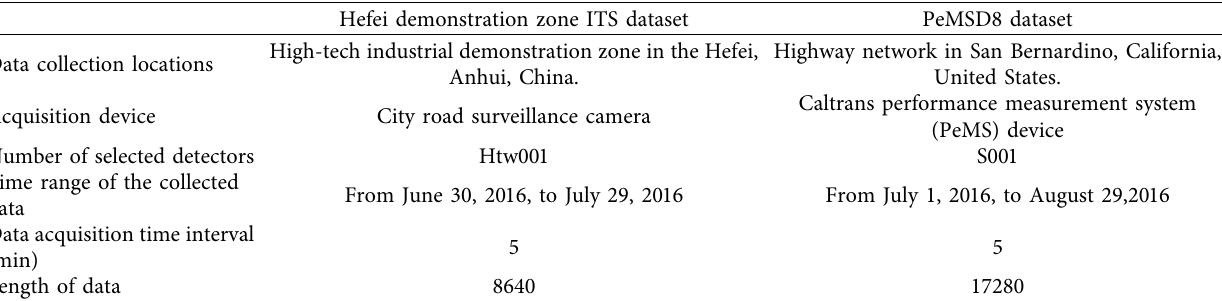
Table 2: Attributes of traffic flow data in the Hefei demonstration zone ITS dataset and PeMSD8